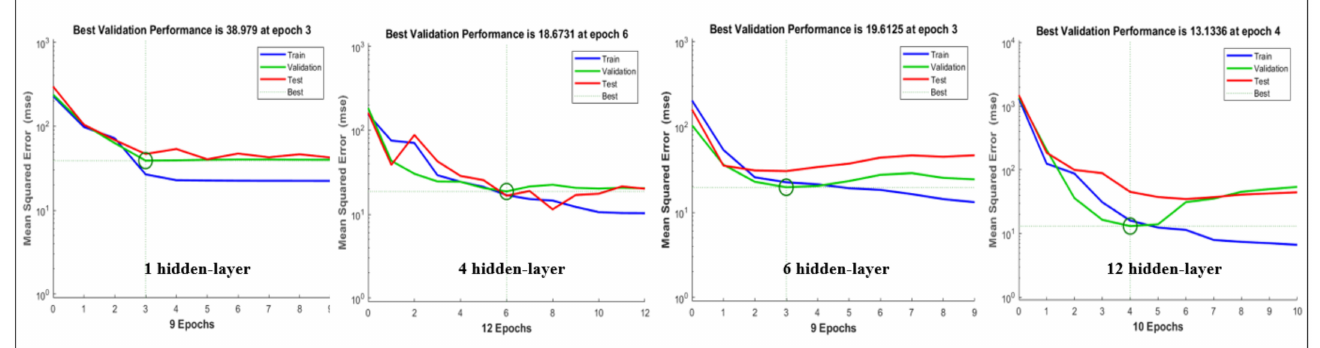
Figure 8. Result of MSE each hidden